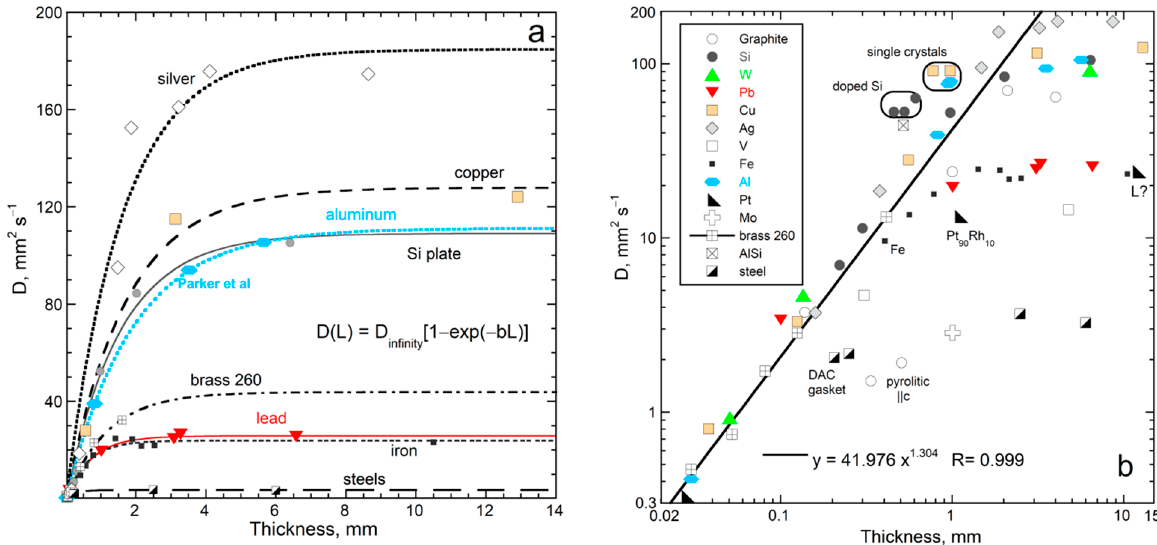
Figure 8. Dependence of D at 298 K on thickness for various elements and alloys: ( a ) Linear plot, showing fits to (22) for elements with >4 measurements over a wide range of L . Parker et al. [11] used an adiabatic model, rather than Cowan’s model used here. ( b ) Expanded view on logarithmic scales showing additional materials, mostly foils, and some single crystals. The power law fit is to brass and only for L < 0.5 mm. The steels are non-magnetic. Foils were obtained from Alfa/Aesar, the Washington U. Physics Department machine shop, and various other sources.